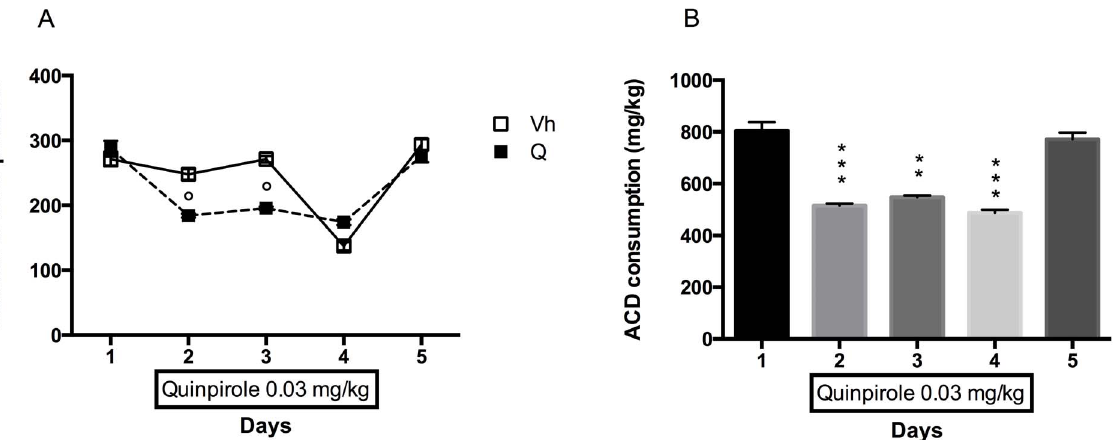
Figure 3. Quinpirole and Relapse. Number of lever presses in Vh and Q groups during Relapse following 1 week abstinence. u p , 0.001 Vs Vh (A). ACD consumption (mg/kg) during Relapse following 1 week abstinence. **p , 0.01; ***p , 0.001 Vs Vh (B).